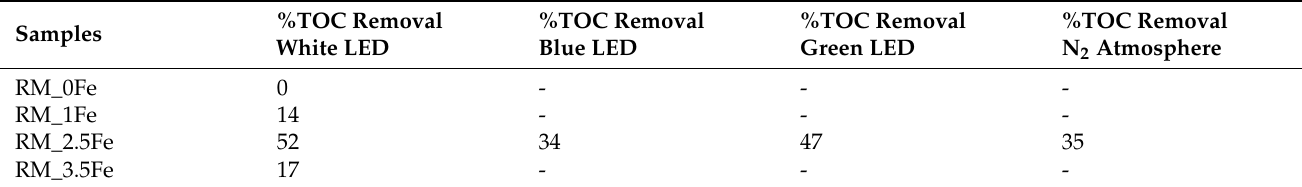
Table 3. TOC Removal (%) after 180 min of light irradiation.